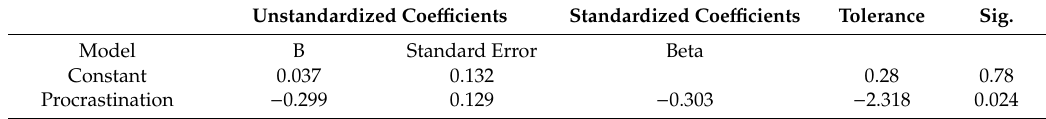
Table 4. Regression model parameters for the orientational level variability (OLV).